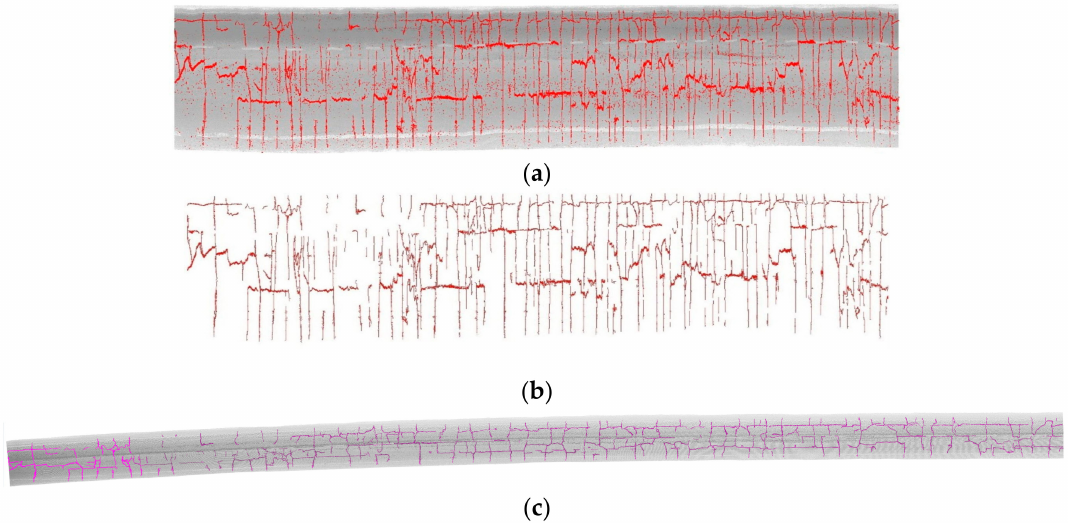
Figure 13. The extracted crack candidates in the Tgrid map and the results of crack craves. ( a ) The extracted crack candidates (in red) on the intensity-based Tgrid map of the road surface, ( b ) the remaining crack candidates after Morphological filtering, and ( c ) overlay of crack craves (in magenta) and road surface point